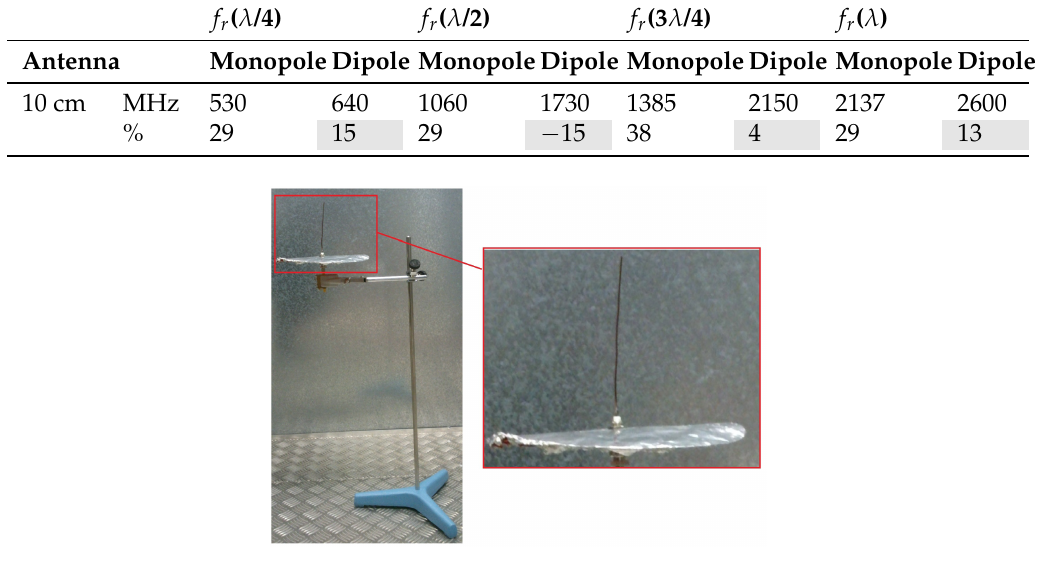
Figure 1. 10 cm monopole with ground plane.